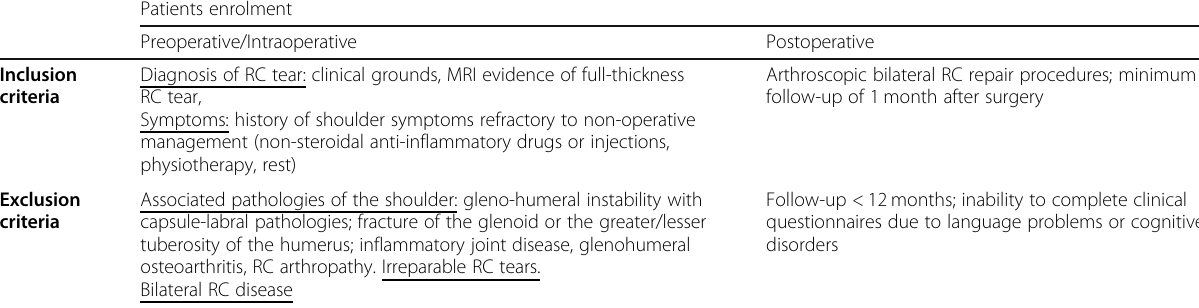
Table 1 Inclusion and Exclusion criteria Patients enrolment Preoperative/Intraoperative Postoperative Inclusion